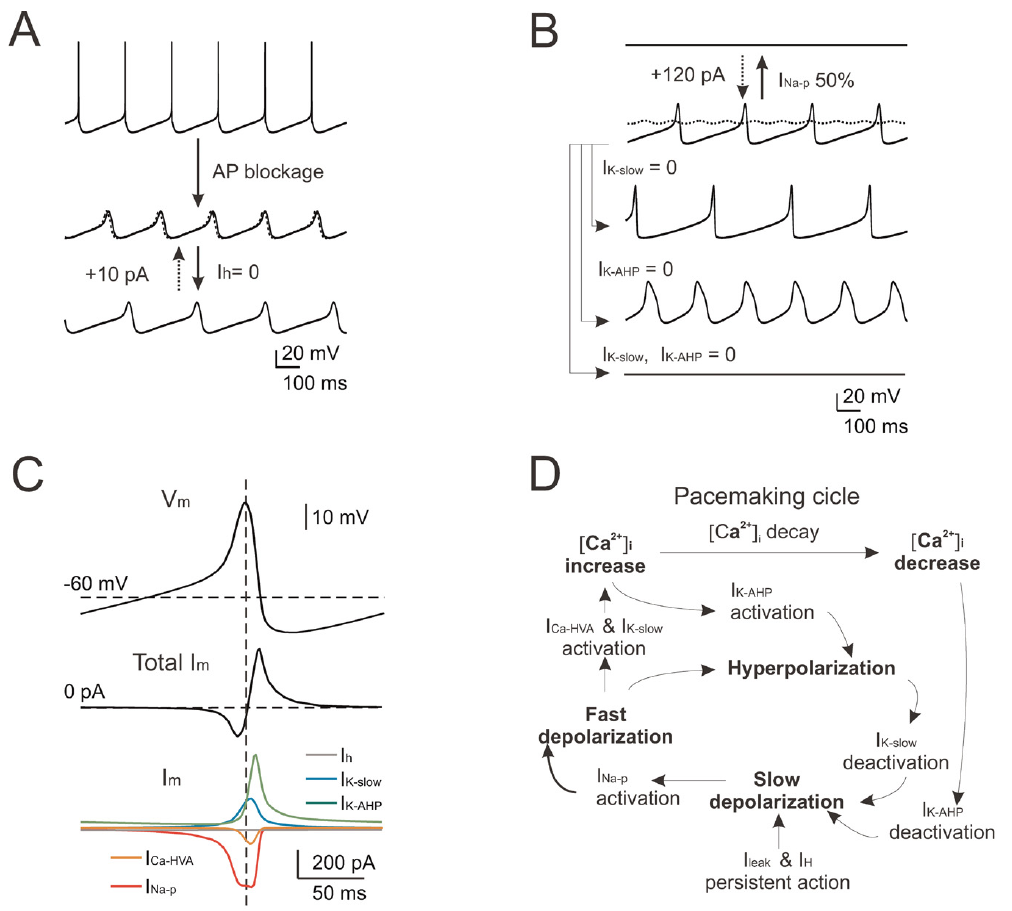
Figure 9. Subthreshold oscillations and spike coupling . In order to investigate the mechanisms of subthreshold oscillations, simulations were performed after blocking the currents generating the spike (I Na-t , I K-V , and I K-C ). ( A ) The simulated traces show that preventing action potentials lead to the emergence of subthreshold pacemaker oscillations slightly slower than in the spiking regime (4.46 vs. 5Hz). Upon 100% I h blockage, the oscillation frequency is reduced (3.3Hz) but the effect is reversed with the injection of a tonic depolarizing current (dashed trace). ( B ) The simulated traces (all voltage-dependent currents blocked except for I Na-p , I K-AHP , I Ca-HVA , and I K-slow ) show that subthreshold pacemaker oscillations are interrupted by blocking I Na-p and that only marginal recovery is obtained by injecting a tonic depolarizing current (dashed trace). Either blocking I K-AHP or I K-slow deforms the oscillation trajectory, while their simultaneous block causes the oscillation to cease. ( C ) The voltage and current traces are shown as a function of time during a full oscillation cycle (all voltage-dependent currents blocked except for I Na-p , I K-AHP , I Ca-HVA , and I K-slow ). ( D ) Schematic showing the cascade of processes that generate pacemaking in the Golgi model